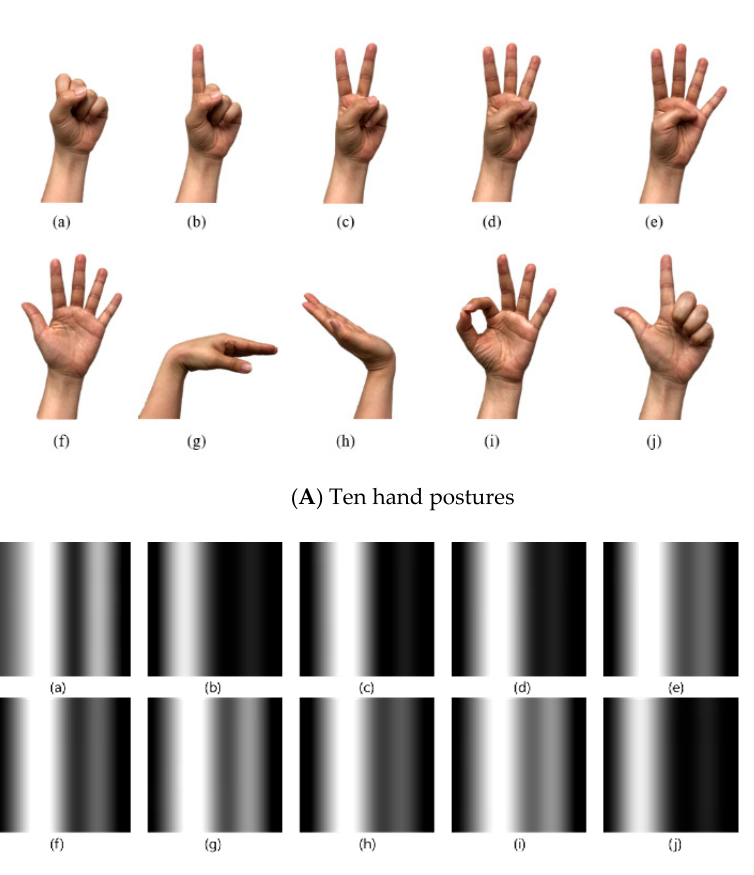
Figure 4. Ten hand postures and their images for the CNN (convolutional neural network) produced from the strain data for pattern recognition; where ( a ) grasp, ( b ) one, ( c ) two, ( d ) three, ( e ) four, ( f ) five (rest), ( g ) wrist flexion, ( h ) wrist extension, ( i ) okay, and ( j ) pinch.